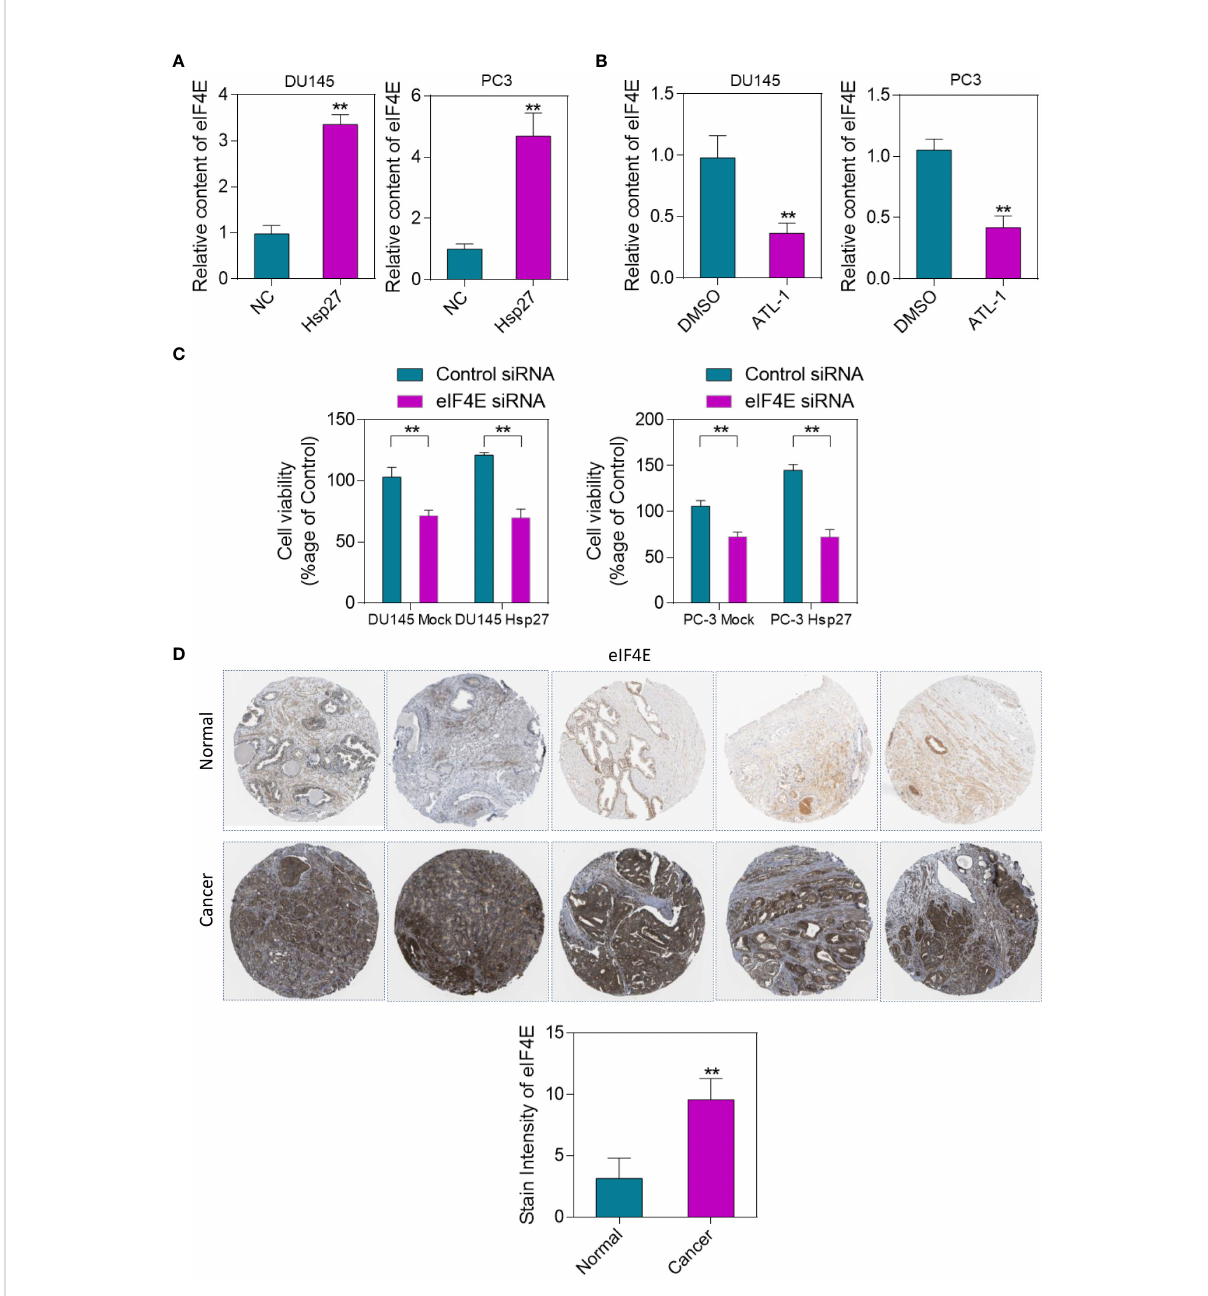
FIGURE 6 Hsp27 regulates eIF4E, mediating cytoprotective effects. (A) PCR analysis of eIF4E levels in DU145 and PC-3 cells stably transfected with empty vector (DU145 and PC-3 Mock) or human Hsp27 (DU145 and PC-3 Hsp27). (B) qRT-PCR analysis of eIF4E expression levels in DU145 and PC-3 cells treated with ATL-1 or DMSO. (C) Quanti fi cation of cell viability in DU145 and PC-3 Mock and DU145 and PC-3 Hsp27 cells treated with 20 nM siRNA control or eIF4E-siRNA and cabozantinib by MTT assay. (D) Changes of eIF4E immunohistochemical staining in human prostate cancer tissues. Immunohistochemical results showed that eIF4E was highly expressed in tumor tissues. **p < 0.01 by two-tailed Student ’ s